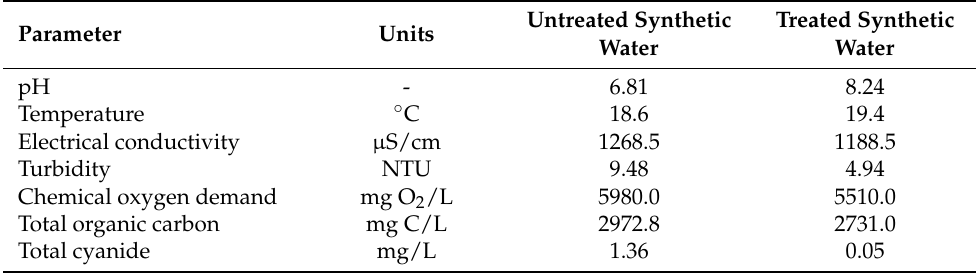
Table 3. Physical–chemical and chemical characteristics of the untreated and treated synthetic water from cassava starch